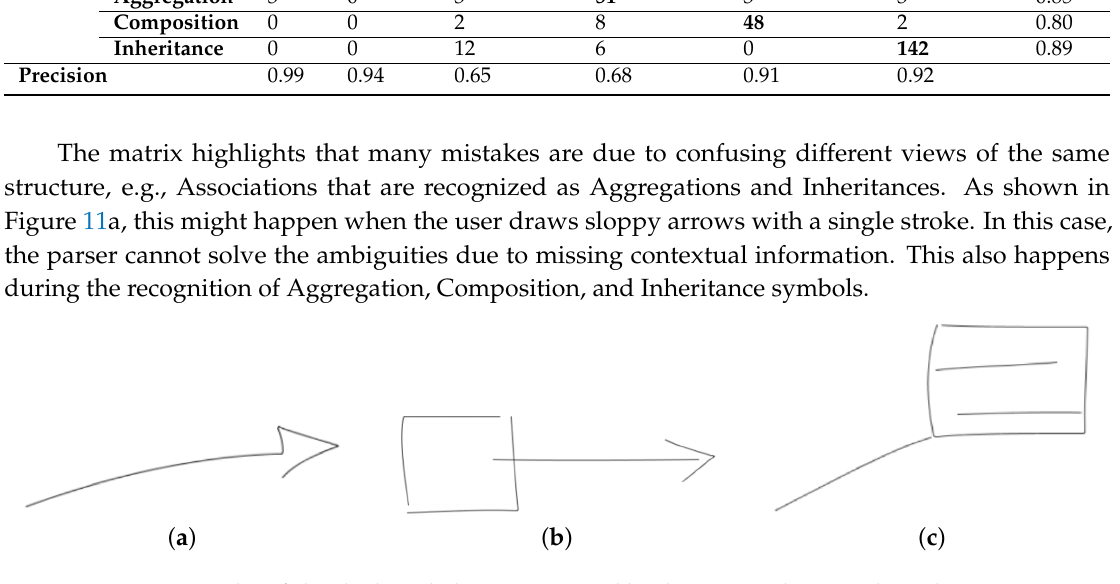
Figure 11. Examples of sketched symbols misrecognized by the proposed approach. A sloppy arrow with a single stroke ( a ); an association symbol positioned on the corner of a messy Class symbol ( b ); an Association and a Class symbol misrecognized as a Composition ( c